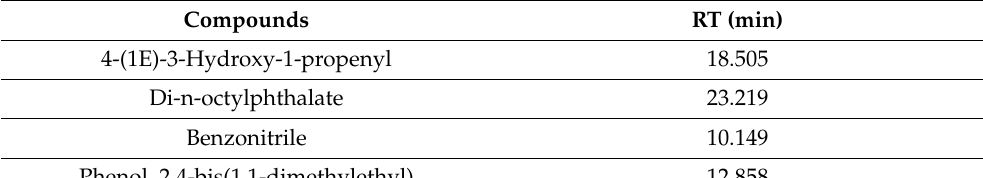
Table 4. Phytochemical compounds of A. garckeana fruit detected by GC-MS analysis. Compounds